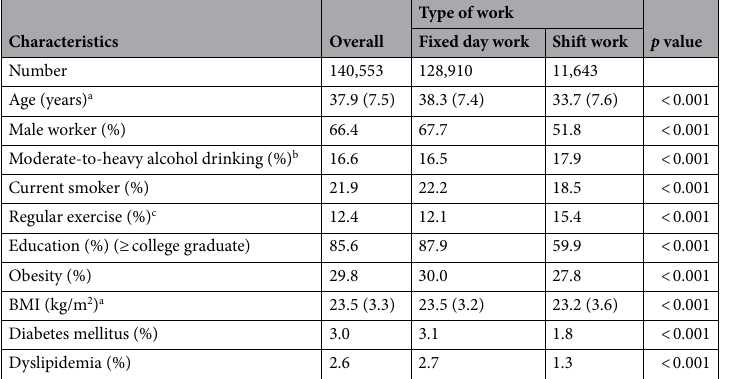
Table 1. Baseline characteristics of study participants by reported type of work. BMI body mass index. a Data are presented as the means (standard deviation). b Data are presented as percentage (≥ 10 g/day). c Data are presented as percentage (≥ 3 times per week).